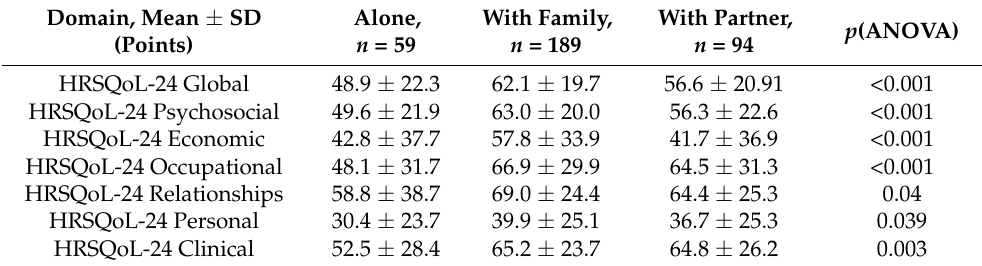
Table 3. HSQoL-24 scores depending on living